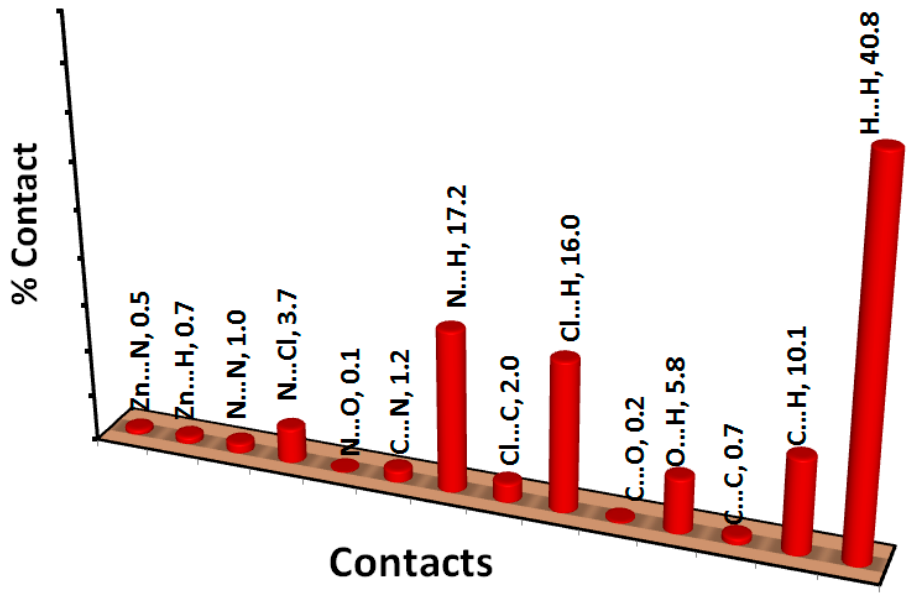
Figure 6. The possible intermolecular contacts and their percentages in the trinuclear Zn(II) complex.